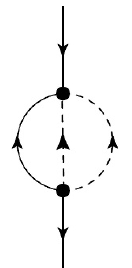
Figure 9 . Leading order quantum corrections to the fermionic propagator in 4+1 dimensions with an n = 4